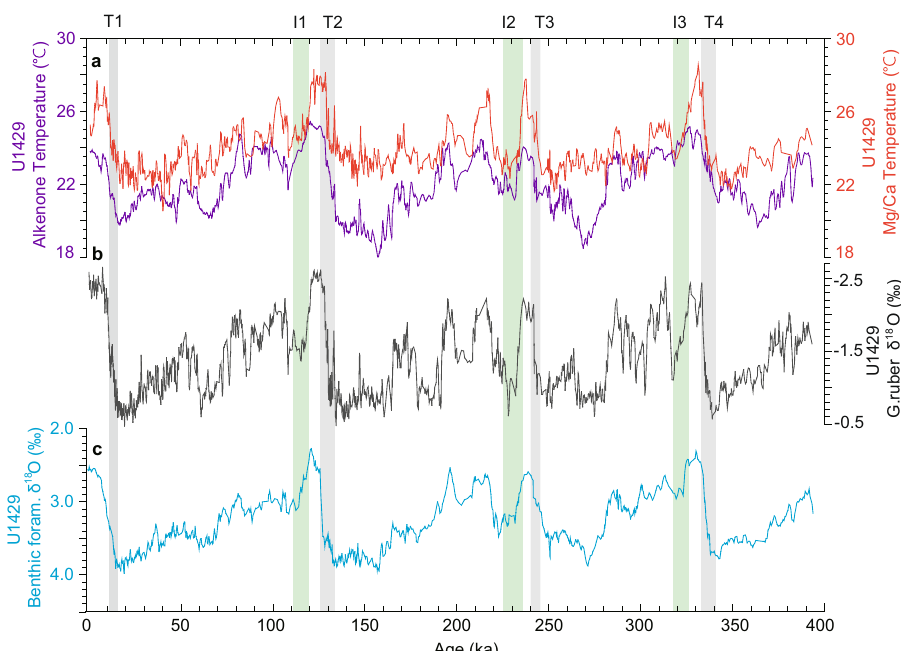
Fig. 8 Time series of reconstructed sea surface temperatures (SST) and foraminiferal δ 18 O at Site U1429. a Alkenone-based temperature record (purple line) and G. ruber Mg/Ca temperature record (orange line). b G. ruber δ 18 O 22 , c benthic foraminiferal δ 18 O 22 . All records are three-point running mean. As all δ 18 O and SST proxies come from the same core material at U1429, there can be little stratigraphic uncertainty when inferring a tight correlation between different kinds of proxy records. Grey and green shaded areas indicate glacial termination and inception, respectively. Glacial inception periods are denoted as I1, I2, and I3 3 , and glacial termination periods are indicated as T1, T2, T3, and T4 23